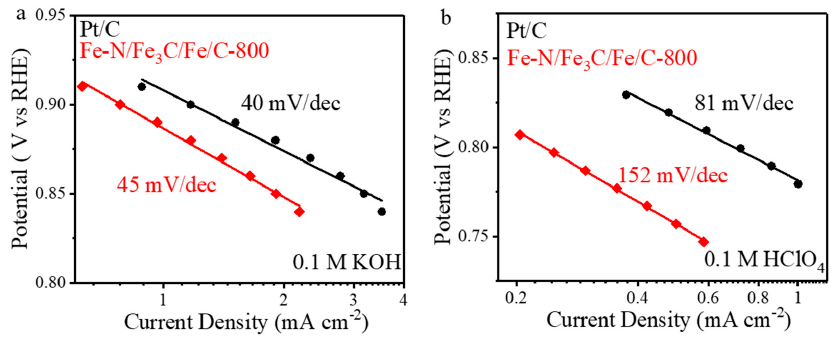
Figure 4. The Tafel plots of Fe-N/Fe 3 C/Fe/C-800 and Pt/C catalysts ( a ) in 0.1 M KOH and ( b ) in 0.1 M HClO 4 .